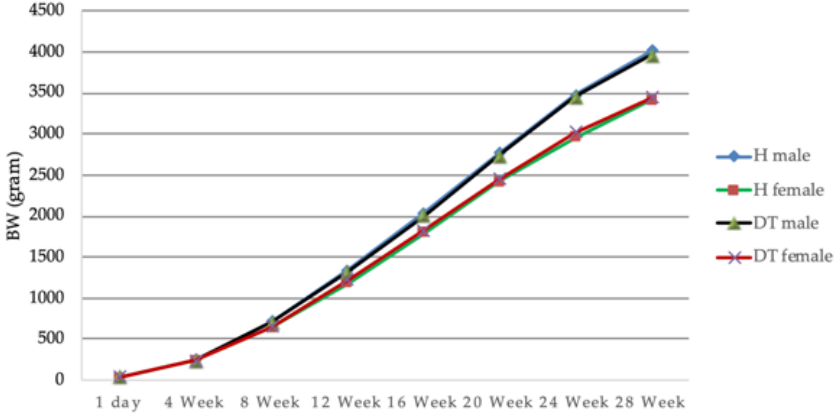
Figure 3. Growth performance of Ho and Dong Tao chickens, H: Ho breed, DT: Dong Tao breed.